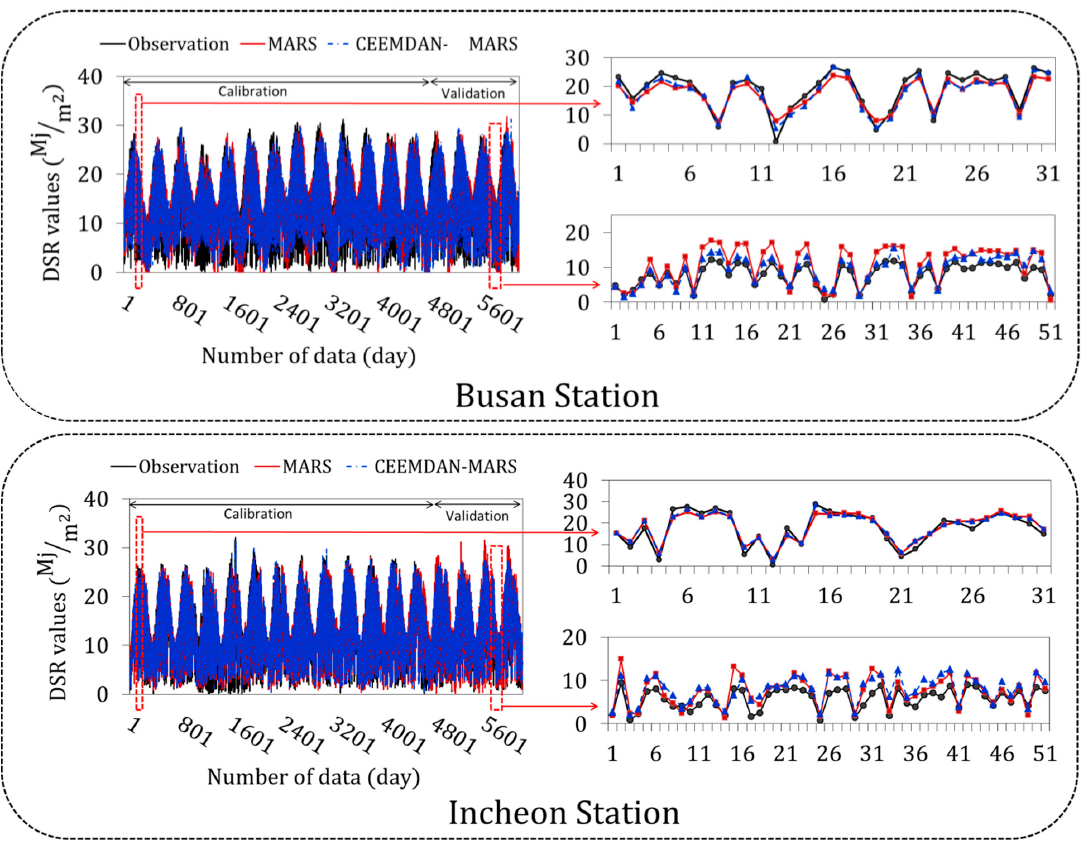
Figure 7. Time-series plots between observed and forecasted DSR for MARS and CEEMDAN-MARS models for the calibration and validation phases at Busan and Incheon.